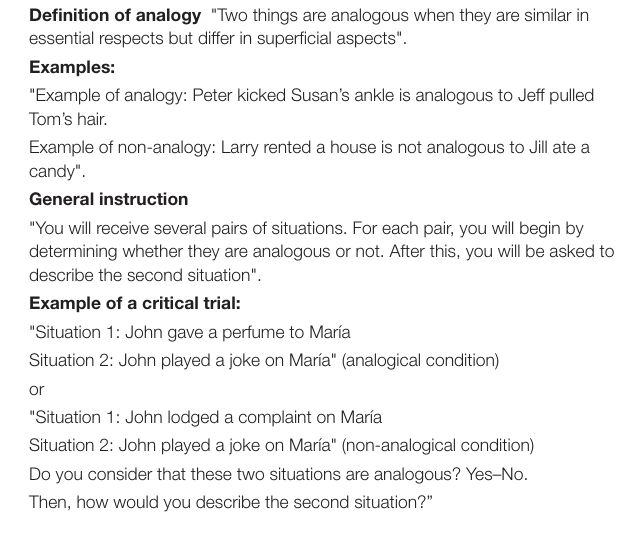
TABLE 3 | Instructions given to participants Experiment